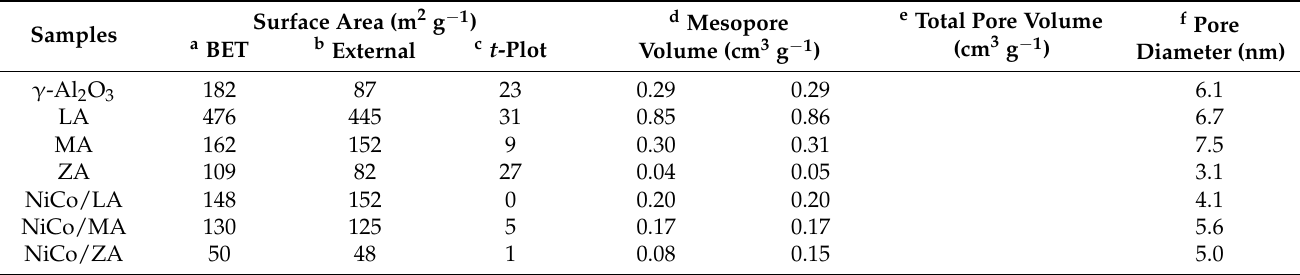
Table 1. Textural properties of the solids in